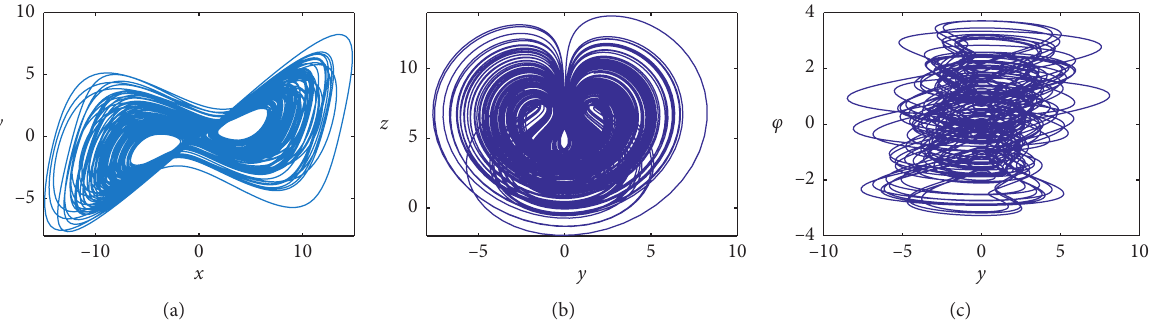
Figure 3: Phase portraits of system (4) with a � 2, b � 3, c � 5, d � 0.75, and k � 1: (a) x - y plane, (b) y - z plane, and (c) y - φ plane.